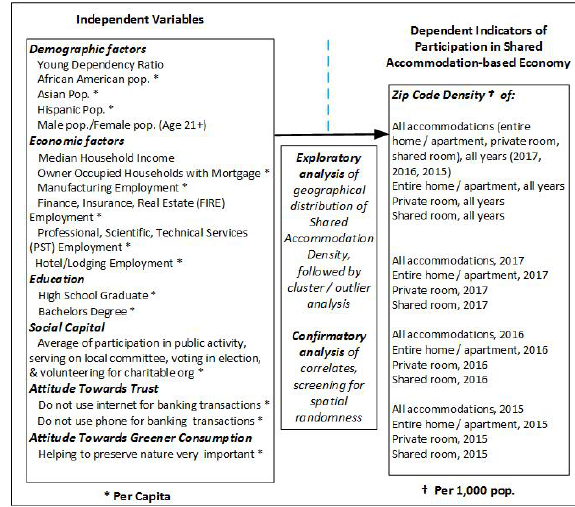
Figure 1. Conceptual model of host participation in shared accommodation-based